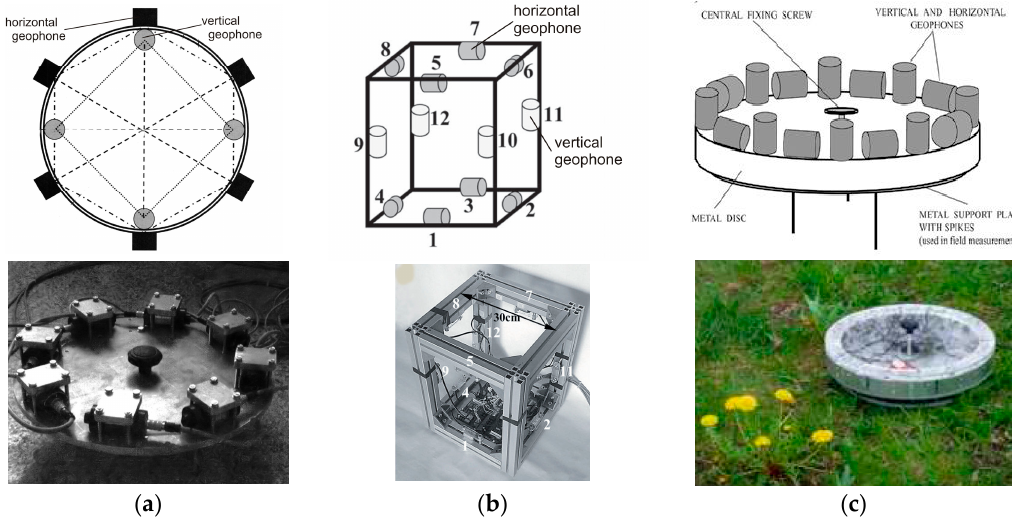
Figure 4. Schematic diagrams of the Rotaphones and general views: ( a ) schematic diagram of 3DOF